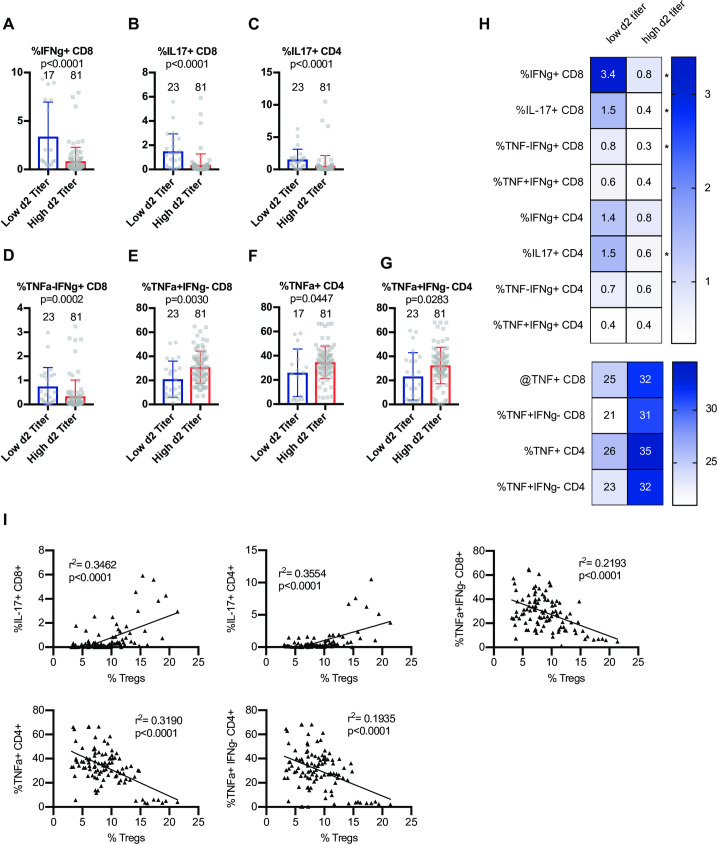
Early viral control upon infection correlates with baseline T cells with a potential to express IFNg or IL17 rather than TNF.Age-matched female CC-RIX were infected intranasally with SARS-CoV MA15 and lung viral loads at day 2 post-infection were used to select CC-RIX lines with extreme phenotypes: “Low 2d Titer” or “High 2d Titer”, as indicated in Fig 1. Mice from a second cohort of 3–6 age-matched male mice of these selected lines were euthanized and splenic cells were treated with anti-CD3/CD28 for intracellular cytokine staining assessment of (A) %IFNg+ of CD8 T cells, (B) %IL-17+ of CD8 T cells, (C) %IL-17+ of CD4 T cells, (D) %TNF-IFNg+ of CD8 T cells, (E) %TNF+IFNg- of CD8 T cells, (F) %TNF+ of CD4 T cells, and (G) %TNF+IFNg- of CD4 T cells. Numbers above the histograms indicate the number of data points (mice) per comparison. Statistical significance was determined by Mann-Whitney test, and Bonferroni correction was applied to correct for multiple comparisons so that p<0.0015625 is considered significant. (H) Heat maps were made to compare the average percent of the indicated cell populations. An asterisk indicates statistical significance of p<0.0015625 as calculated above after correction for multiple comparisons. (I) The correlation between the baseline splenic frequency of Tregs (% Foxp3+ of CD4 T cells) and % of CD8 T cells that are IL-17+, % of CD4 T cells that are IL-17+, % of CD8 T cells that are TNF+IFNg-, % of CD4 T cells that are TNF+, and the % of CD4 T cells that are TNF+IFNg- are shown with linear regressions for mice from all CC-RIX lines with low or high day 2 titer.